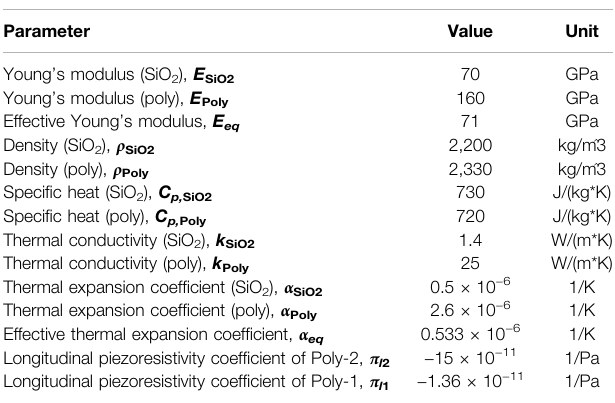
TABLE 2 | Material parameter values for